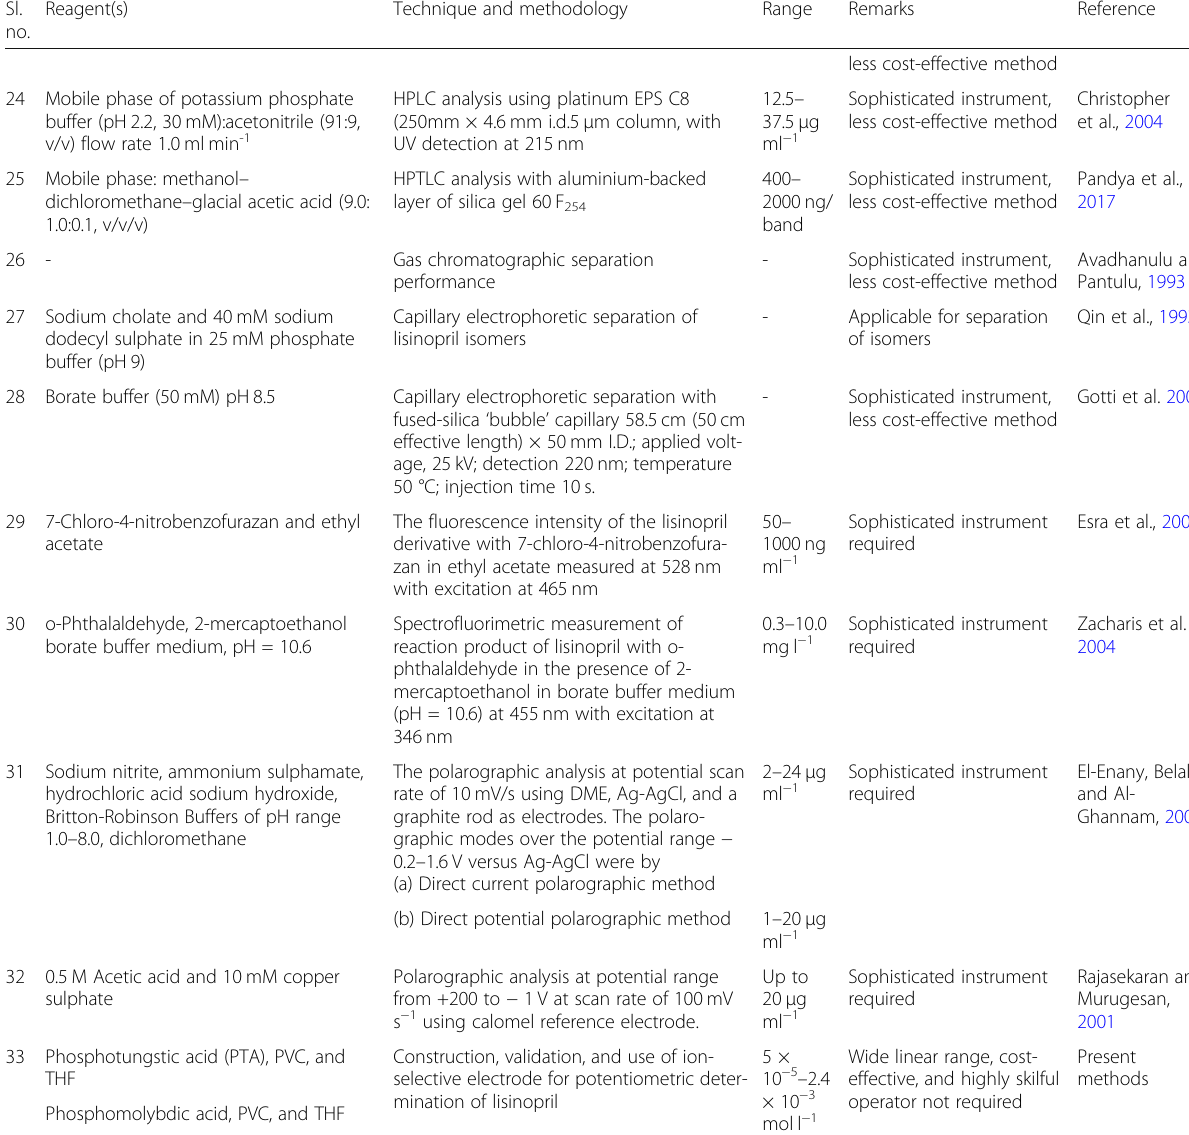
Table 1 Performance characteristics of existing methods of LNP (Continued) Sl. no.